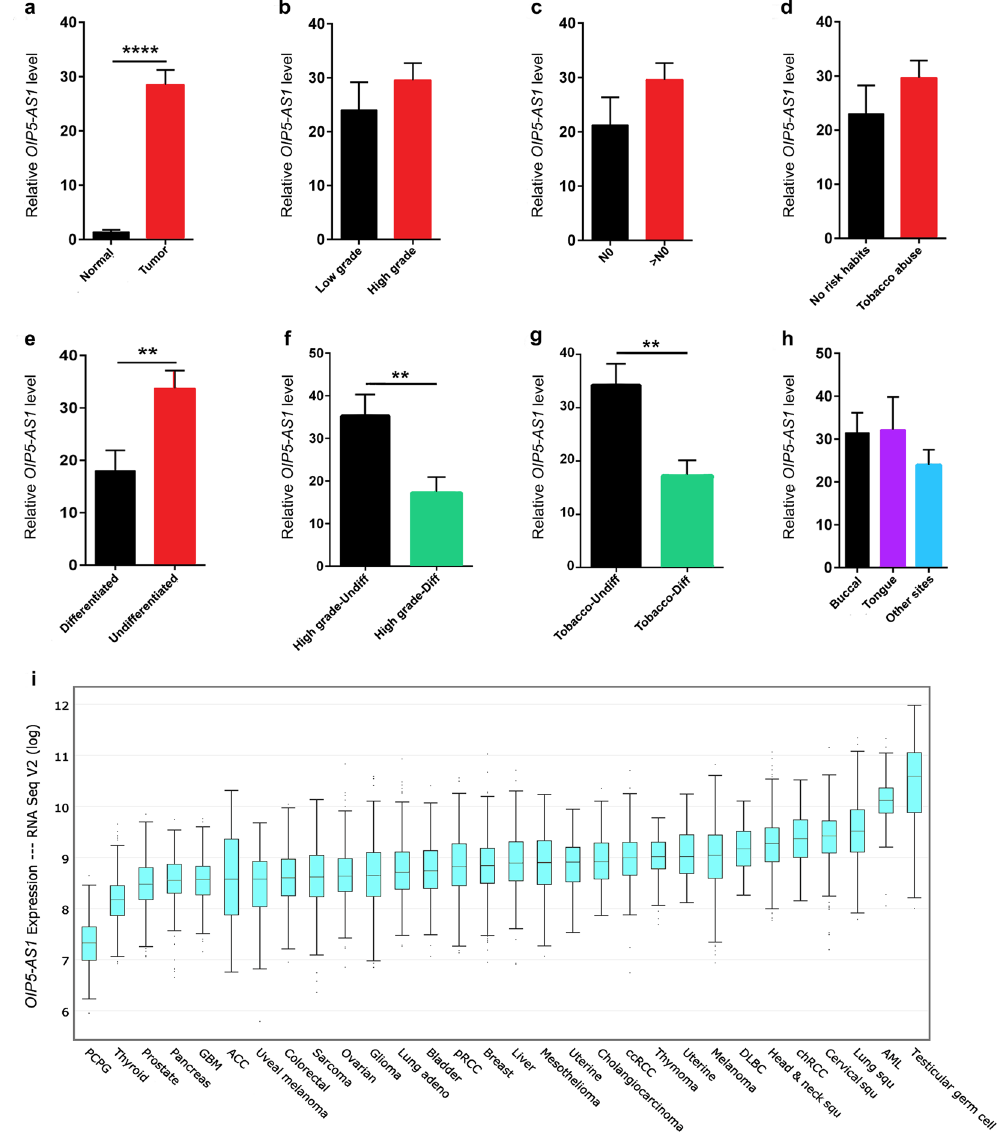
Figure 1. Expression analysis of OIP5-AS1 in various human cancers. ( a ) Relative expression level of lncRNA OIP5-AS1 in oral tumors compared with normal tissues. ( b ) Expression level of OIP5-AS1 between tumor grade, ( c ) tumor nodal stage, ( d ) oral cancer risk habits, ( e ) tumor cell differentiation pathology. ( f ) Relative expression level of OIP5-AS1 between differentiated and undifferentiated oral tumors in high tumor grade, ( f ) in patients having tobacco abuse. ( h ) Expression of OIP5-AS1 between the tumor sites. Statistical significance represented as ** for P < 0.01 and **** for P < 0.0001 (two-tailed Student’s t-test). ( i ) Expression pattern of OIP5-AS1 in the spectrum of cancers from TCGA database. Testicular germ cell tumors expressed lncRNAs OIP5-AS1 at high level followed by AML and cancers of squamous epithelial origin including head and neck. Data points are presented in log